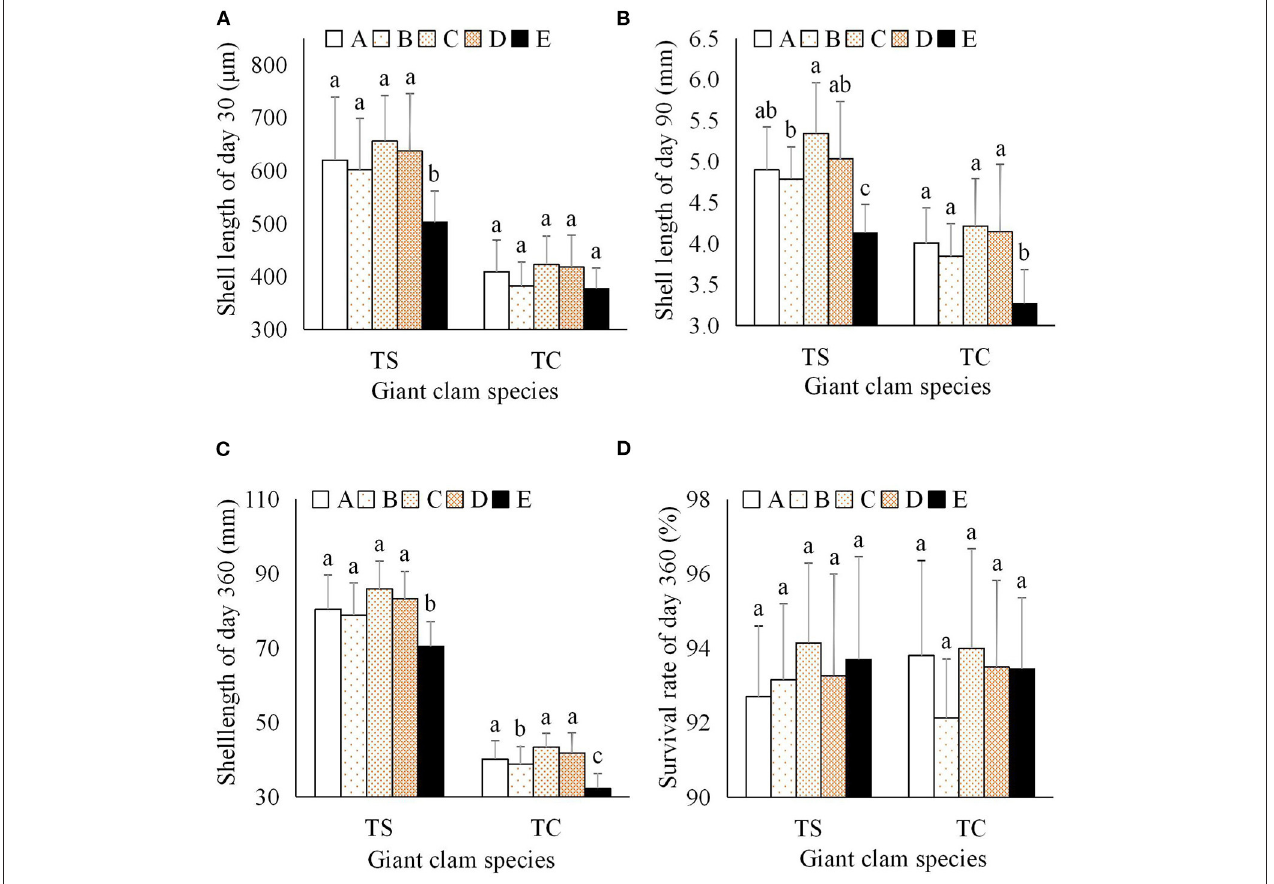
FIGURE 5 | Effects of zooxanthellae clades A–E on growth and survival indices of T. squamosa and T. crocea progeny. (A) Shell length at day 30; (B) Shell length at day 90; (C) Shell length at day 360; (D) Survival rate at day 360.